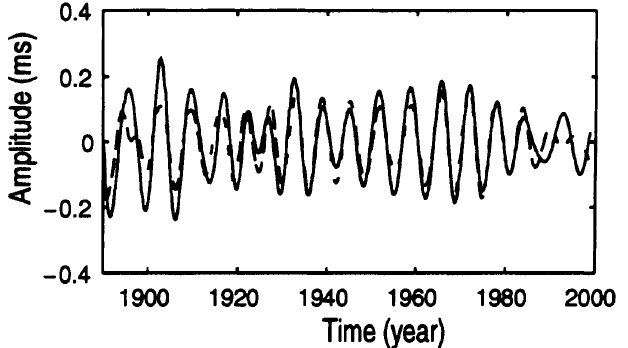
Fig. 4. Amplitude diagram of the wavelet transform of LOD- NCEP 10 time series. Contour intervals at 0.025 ms intervals